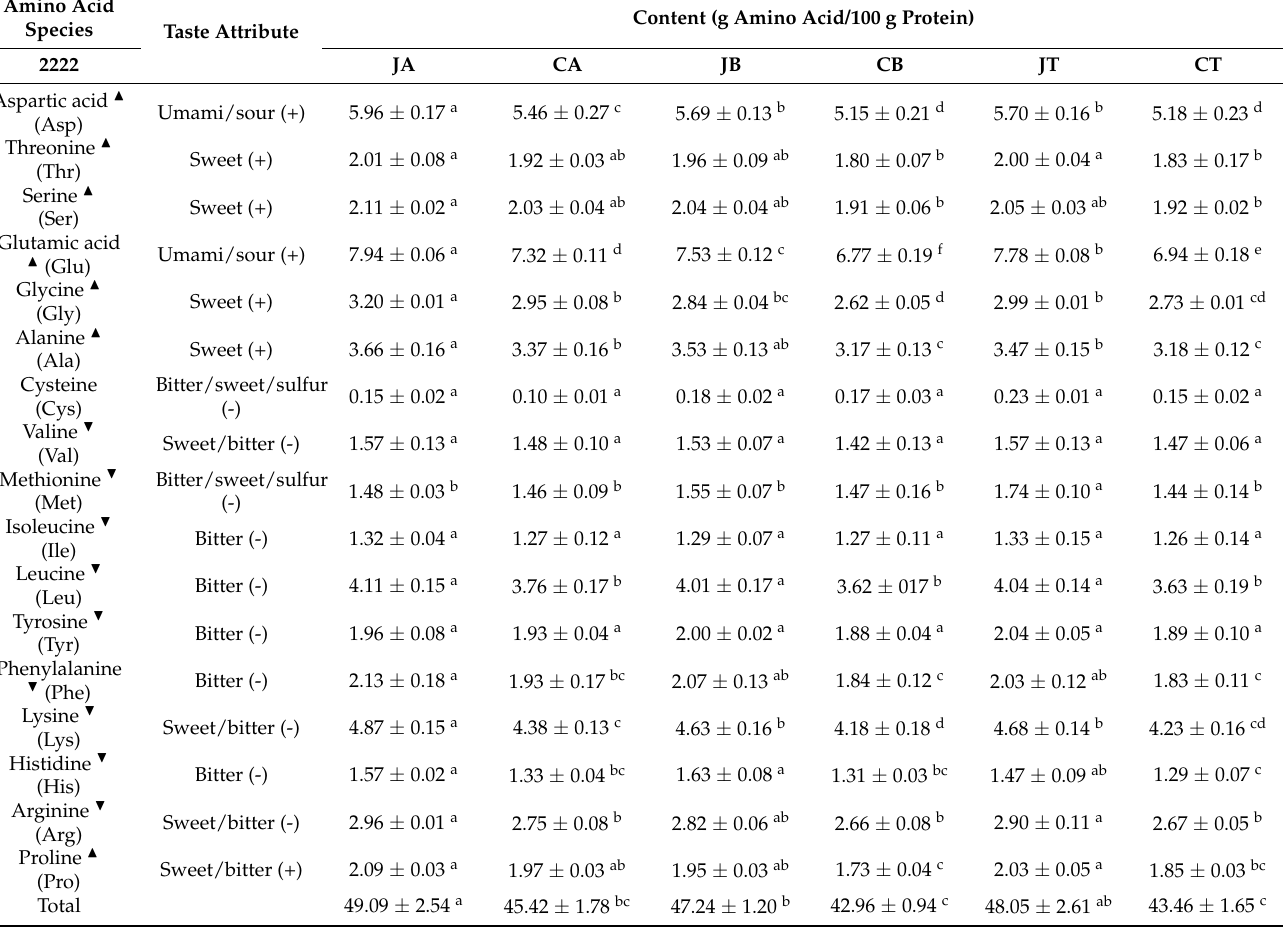
Table 3. Comparison of amino acids in different parts of JPGC and CGC.